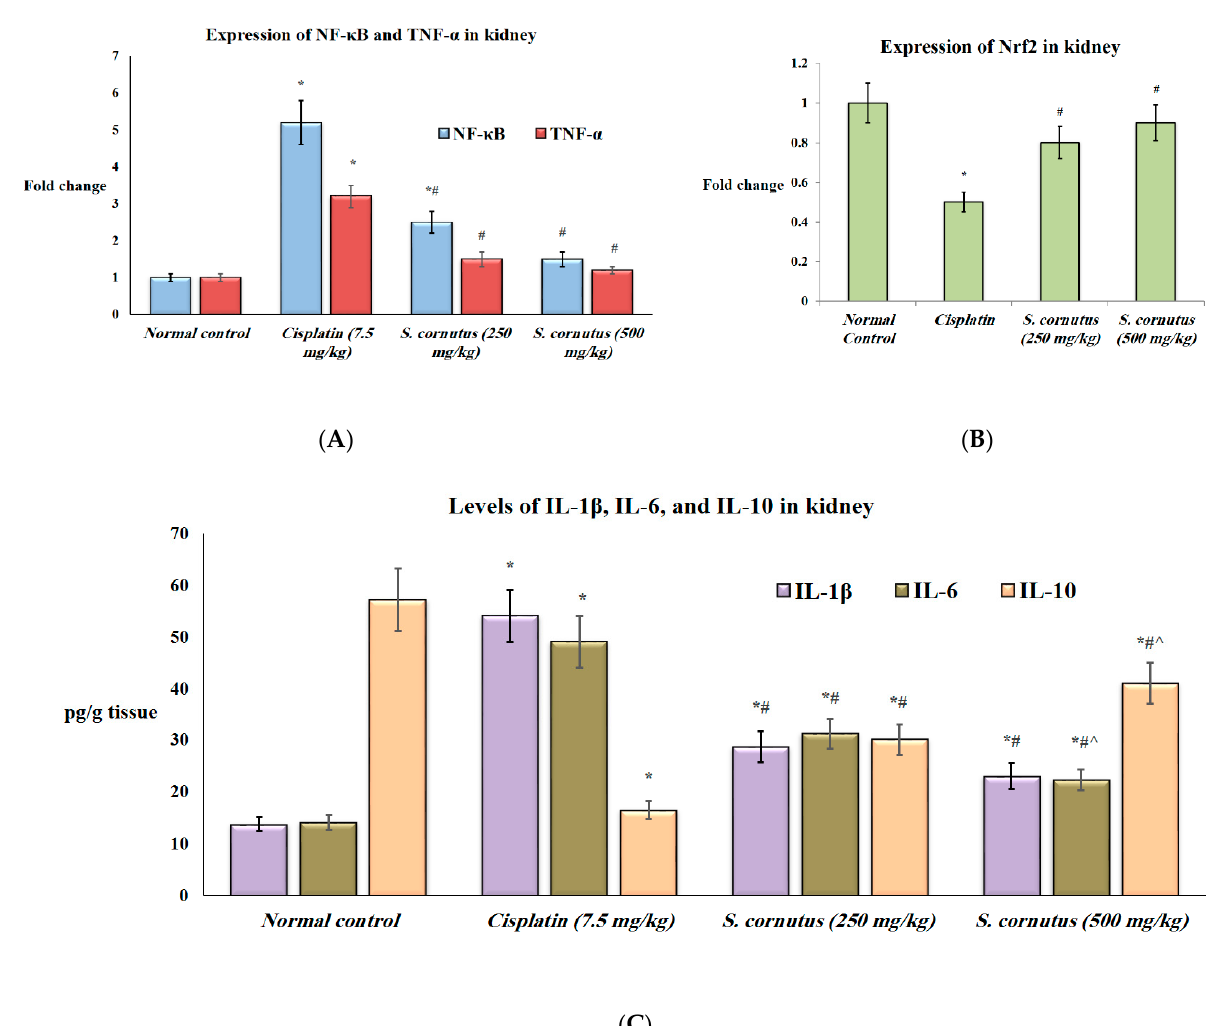
Figure 3. The effect of S. cornutus crude extract on the expression and protein levels of inflammtory markers in the kidney tissue of the experimental mice. ( A ) NF- κβ and TNF- α expression, ( B ) Nrf2 expression, ( C ) Il-1 β , IL-6, and IL-10 levels. NF- κβ = nuclear factor kappa B; TNF- α = tumor necrosis factor- α ; Nrf2 = nuclear factor-erythroid factor 2-related factor 2; IL = interleukin. Data are expressed as mean ± SD and analyzed using one-way ANOVA followed by Bonferroni’s post hoc test ( n = 8). * significantly different vs. the normal control group; # significantly different vs. the cisplatin group; ^ significantly different vs. the S. cornutus (250 mg/kg) group. Differences were considered significant at p < 0.05.